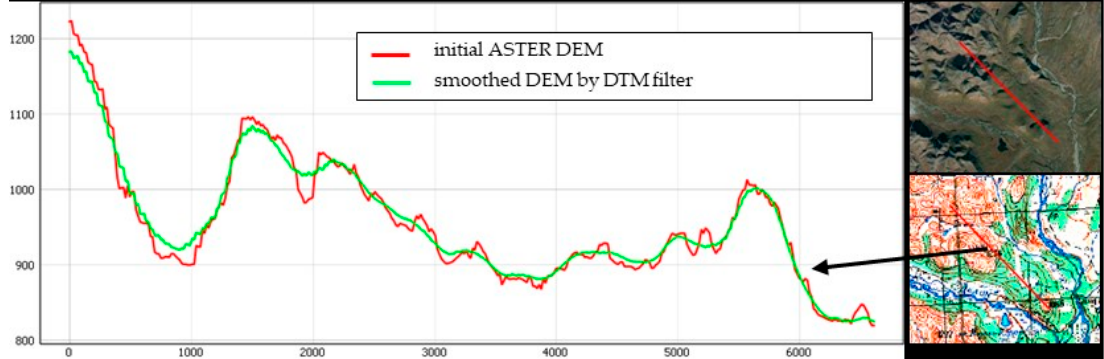
Figure 4. Example of hypsometric profile made by ASTER